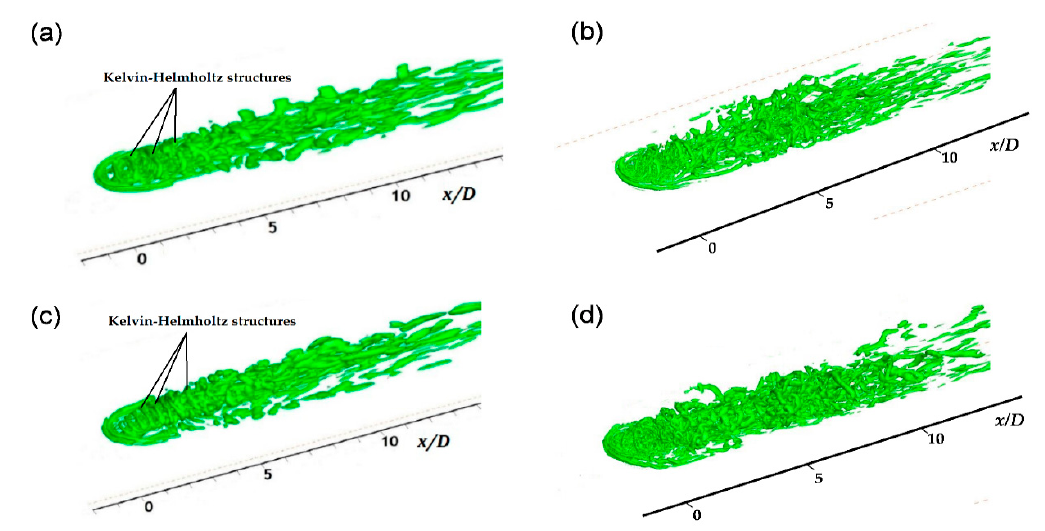
Figure 12. Isosurface of the second invariant of the velocity gradient tensor (Q): ( a ) M = 0.5, β = 0°; ( b ) M = 0.5, β = 30°; ( c ) M = 1.0, β = 0°; and ( d ) M = 1.0, β = 30°.